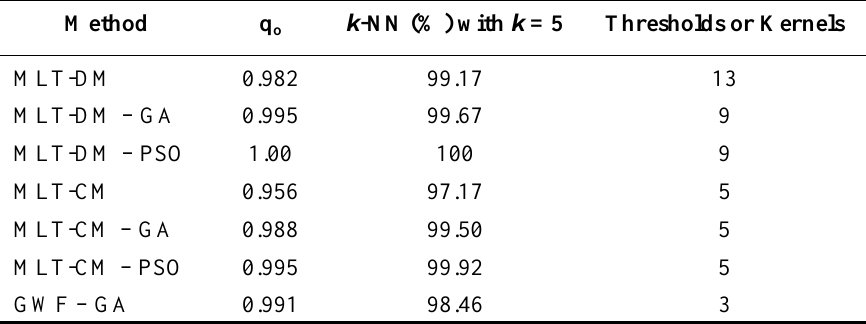
Table 5. Results of MLT-DM and MLT-CM configured by human expert (Manual), GA and PSO (Automated) and result of GWF configured by GA